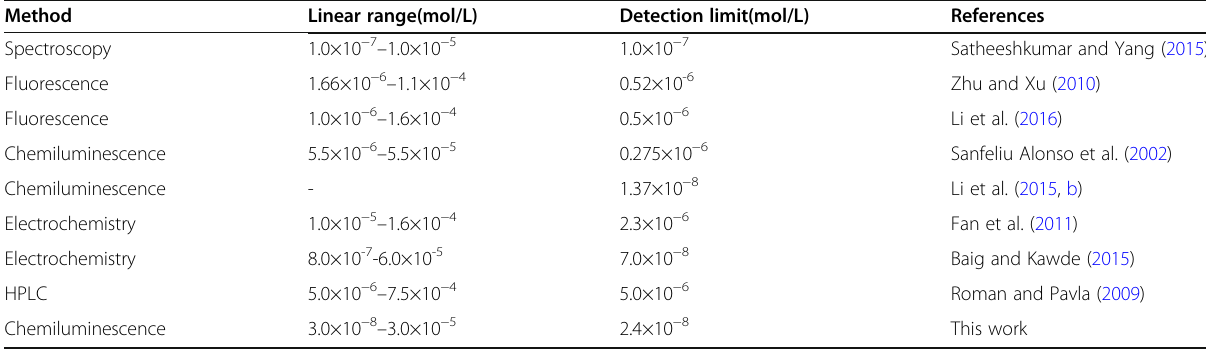
Table 3 Comparison of different methods for detecting Tyr